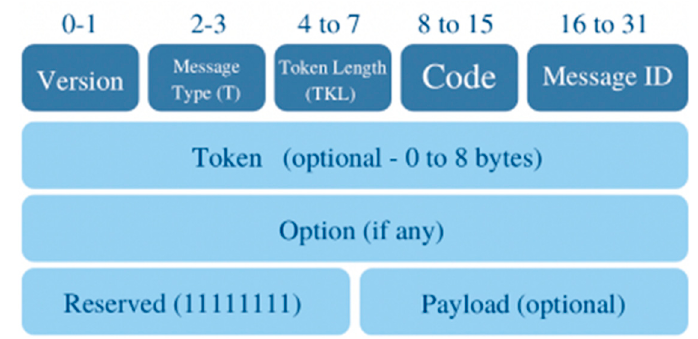
Figure 17. CoAP message